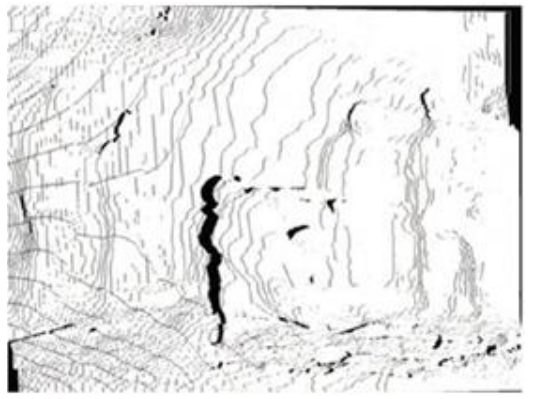
Figure 1: Color image to a virtual viewpoint composite image conversion